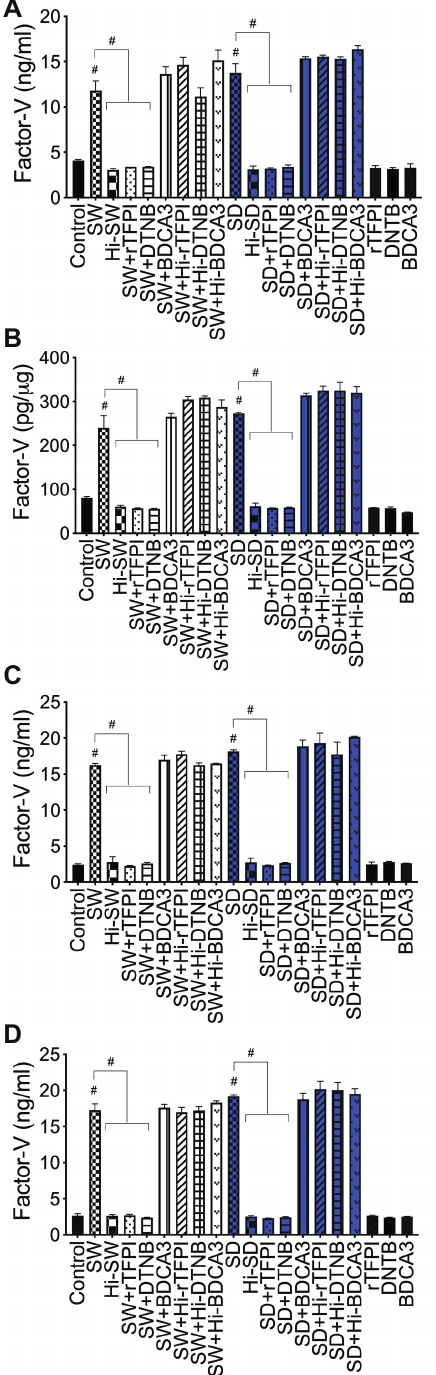
Figure 7. rTFPI and thiol blockers prevent S-protein-induced Factor-V expression and release in HLMEC, whereas TM had no effect: ( A , B ) HLMEC treated (24 h) with S-proteins (1 nM SW or SD), with or without rTFPI, DTNB, and BDCA3 (200 ng/mL); ( C ) HLMEC were treated 6 h with S-proteins, with or without rTFPI, DTNB, and BDCA3, washed, and co-cultured with neutrophils for 24 h; ( D ) human neutrophils were treated 6 h with S-proteins, with or without rTFPI, DTNB, and BDCA3, washed, and co-cultured with HLMEC for 24 h. Following treatments, Factor-V levels in culture supernatants ( A , C , D ) and endothelial cells lysates ( B ) were quantified by ELISA. Data presented as mean ± standard deviation. Control: untreated cells; Hi: heat-inactivated (SW, SD, rTFPI, DTNB, BDCA3). # p <